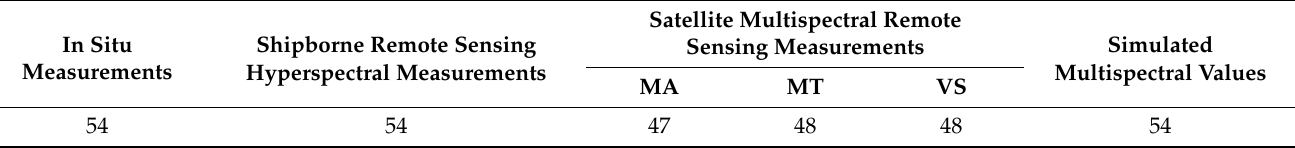
Table 2. The number of points in each type of data